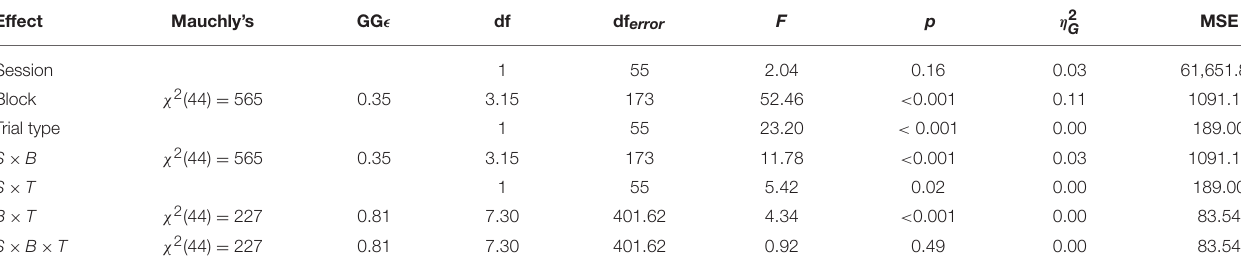
TABLE 3 | Analysis of variance for ASRT with reaction time (RT) as dependent measure.